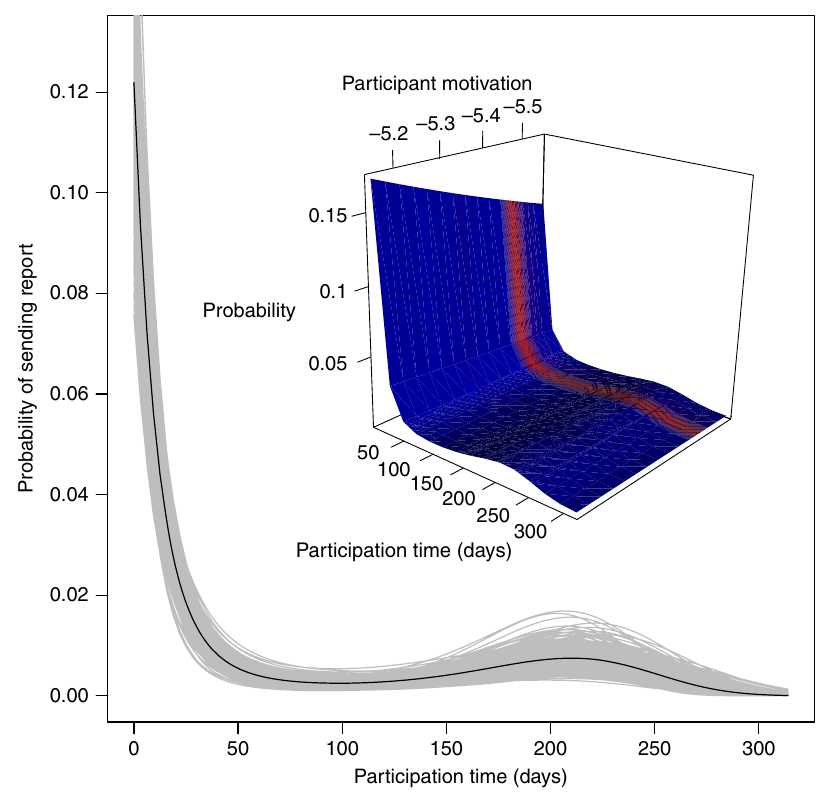
Fig. 4 Reporting propensity. Probability of participant sending at least one report during a 24-h period as a function of participation time and participant ’ s intrinsic motivation (modelled as random intercept at participant level). Main: values for the mean random intercept. Each grey curve is based on a random draw from the posterior distributions of the participation time parameters; black is based on the mean of the posteriors. Inset: prediction surface with participant motivation (random intercepts) shown on x axis as continuous variable in observed range; surface colour represents density of participants at each random intercept value (red = higher; blue =